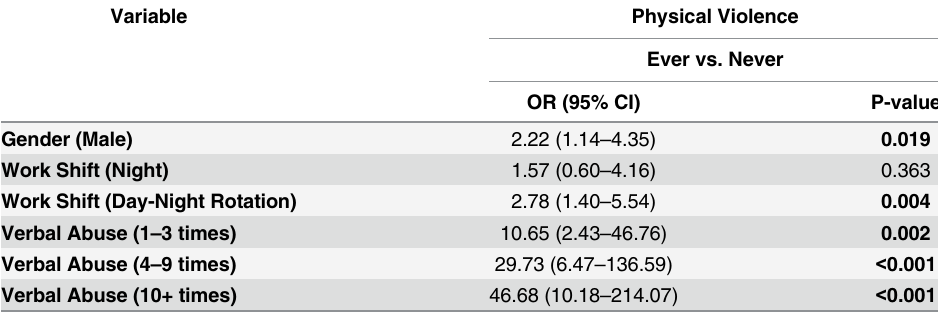
Table 5. Binary logistic regression model on exposure to physical